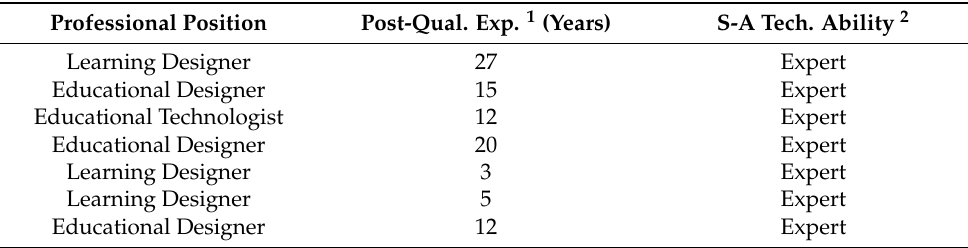
Table 3. Demographics and characteristics of Learning Designers * (LDs) as ‘Digital’ (interaction) ‘expert’ working in higher education to design digital learning experiences. Professional